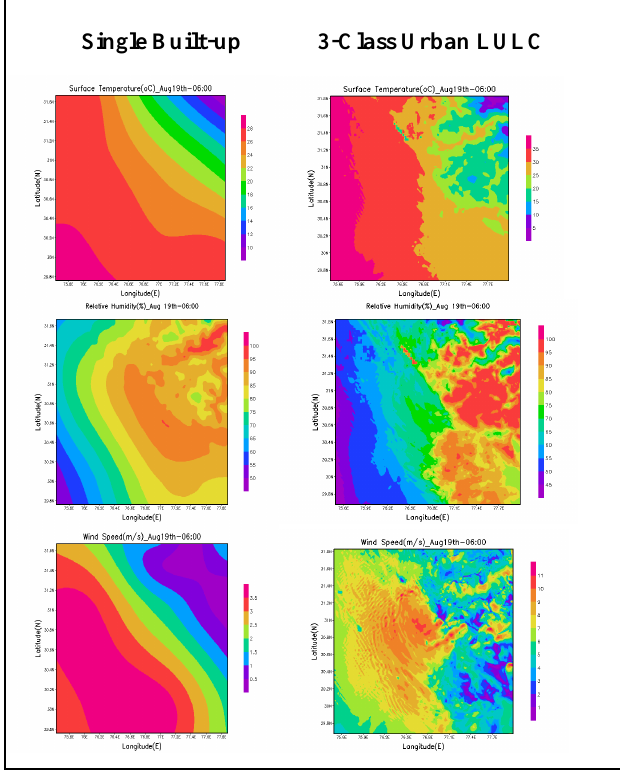
Figure 6. Spatial distribution of Temperature,